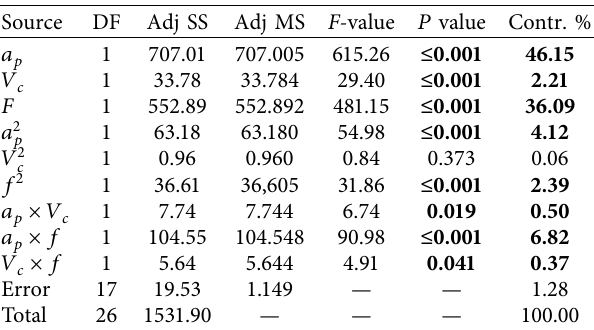
Significant P values are marked in bold. Table 7: Analysis of variance for energy consumption.